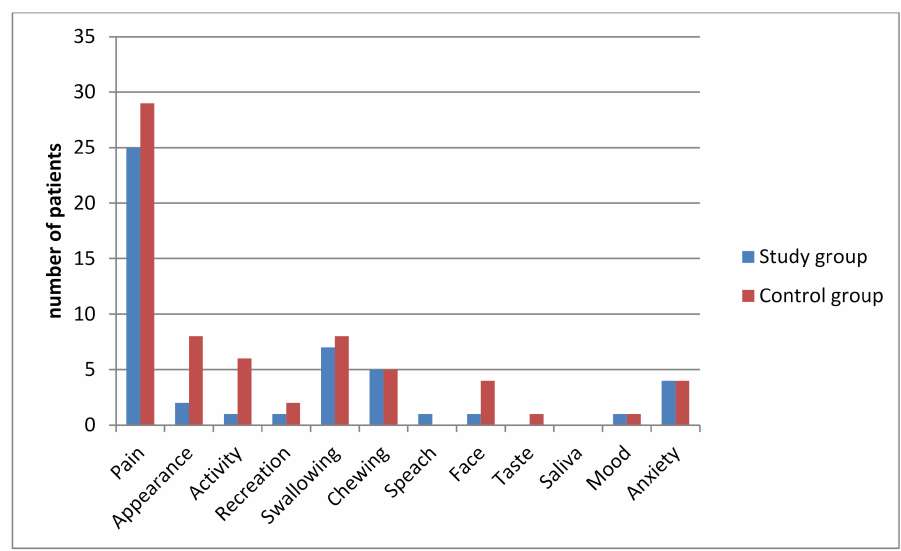
Figure 3. Significant problems for patients during recovery after removal of